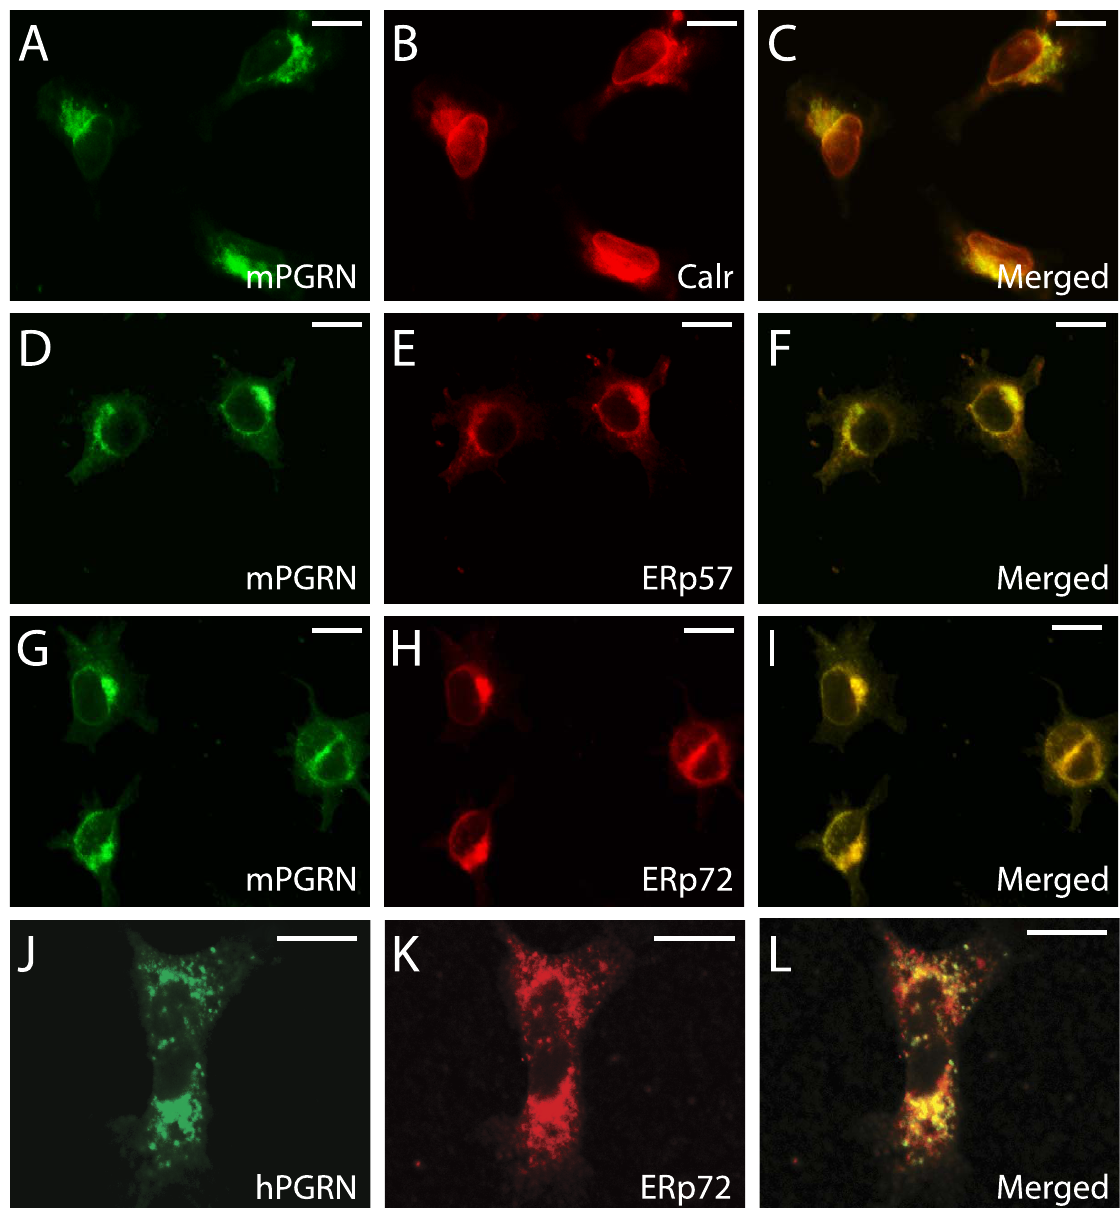
Figure 3. Co-localization of mPGRN-HA with its interacting proteins in HEK293 cells. ( A, D, G ) Subcellular localization of mPGRN in HEK293 cells. ( B , Co-immunostaining of cells in (A) with anti-calreticulin (Calr) antibody. ( C ) the merged image of (A) and (B). ( E ) Co-immunostaining of cells in (D) with anti-ERp57 antibody. ( F ) The merged image of (D) and (E). ( H ) Co-immunostaining of cells in (G) with anti-ERp72 antibody. ( I ) Merged image of (G) and (H). The mPGRN antibody did not recognize endogenous hPGRN in HEK293 cells. ( J ) Subcellular localization of endogenous hPGRN in HEK293 cells. ( K ) Subcellular localization of endogenous ERp72 in HEK293 cells. (L) Merged image of (J) and (K) indicates that endogenous hPGRN also largely co-localizes with ERp72. Note that the size of scales bars in J–K are different from A–I and mPGRN is overexpressed in A–I and shows a stronger signal in the ER. Scale bars: A–I, 10 m m; J–L, 10 m m.